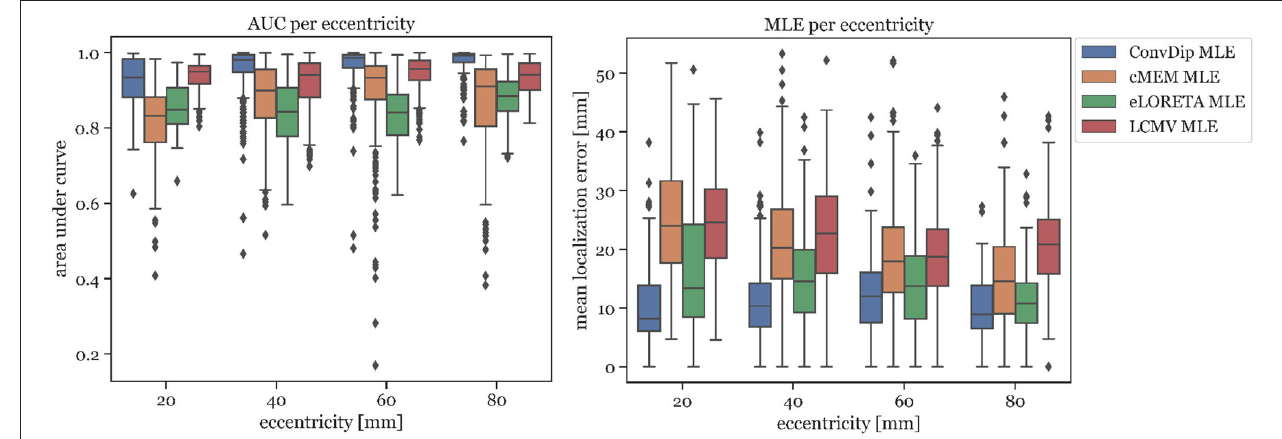
FIGURE 3 | Area under the curve and mean localization error for each inverse algorithm grouped by the source eccentricity. Simulations used for this analysis contained only a single source cluster per sample of varying size from two to seven neighborhood orders.